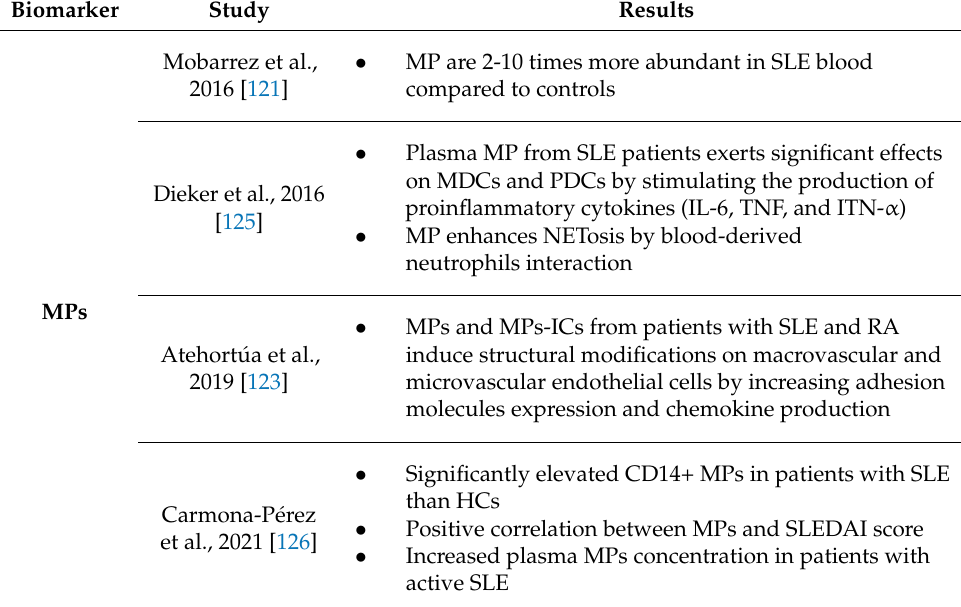
Table 7. Microparticles in SLE